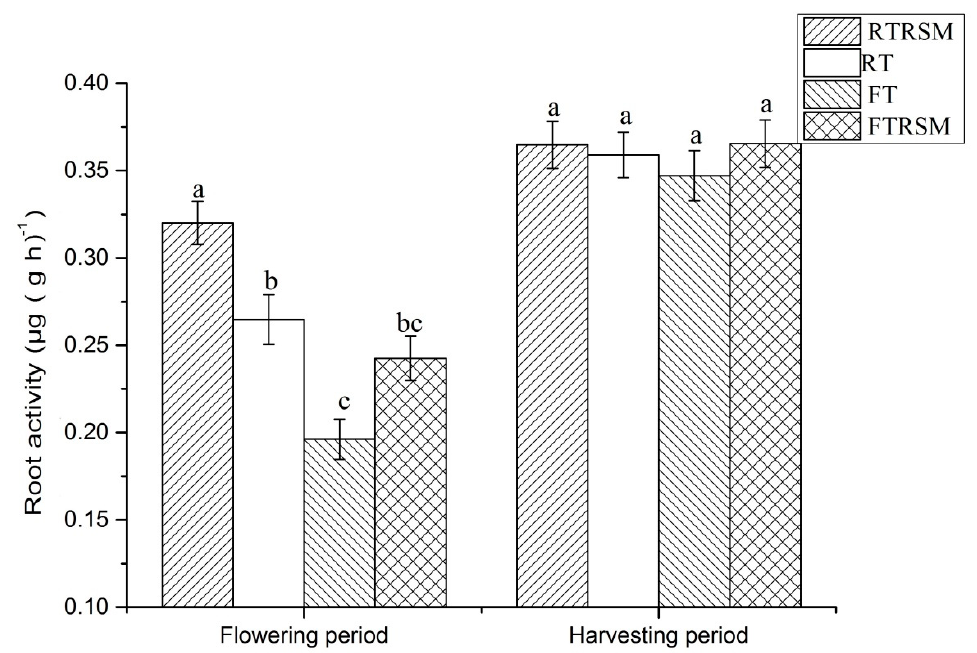
Figure 4. The root activity of faba bean under different treatments at different periods. FT. flat tillage without any mulch;